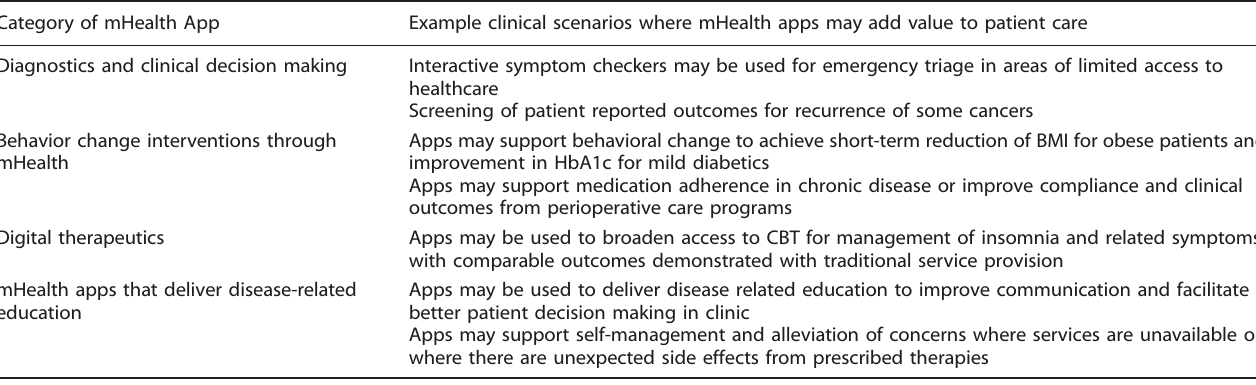
Table 1. Clinical scenarios where evidence suggests that apps may add value to patient care.